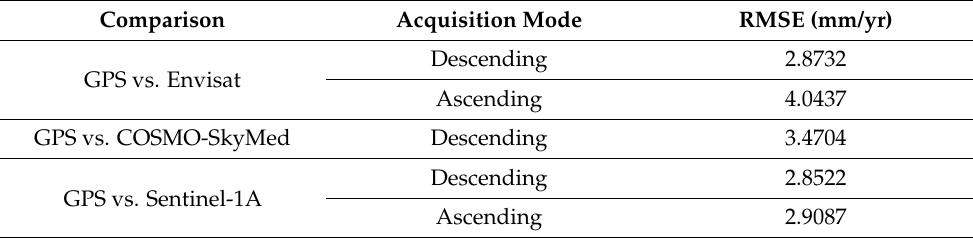
Table 2. RMSE calculated for each comparison made between GPS displacement rates reprojected on satellite LOS and that deriving from the SAR data